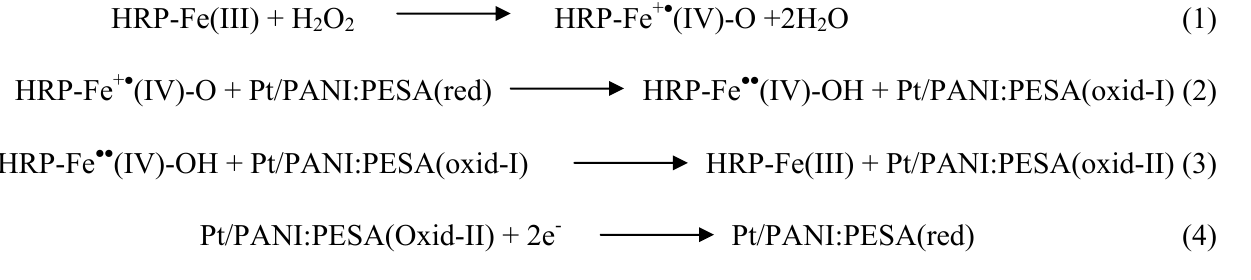
Figure 7. (A) Cyclic voltammograms of the biosensor responses to H phosphate buffer pH 6.5; (B) Calibration plot of the biosensor for H